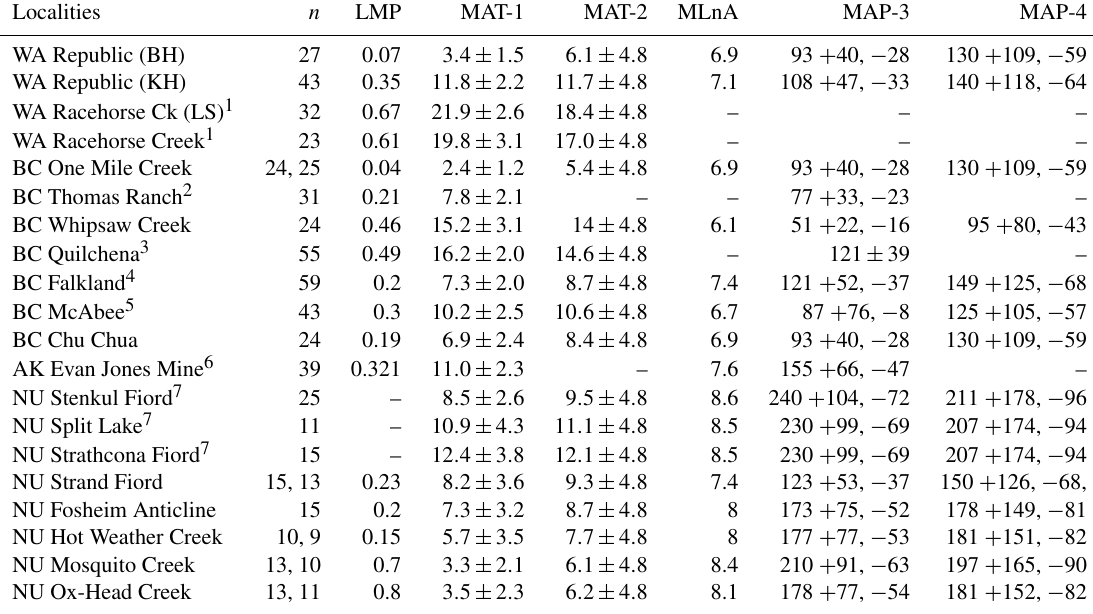
Table A2. Paleoclimate estimates from leaf margin analysis (LMA: Wing and Greenwood, 1993; Wilf, 1997; Peppe et al., 2011) and leaf area analysis (LAA: Wilf et al., 1998; Peppe et al., 2011). Unless otherwise specified, data and estimates are original to this study. See Table 1 for locality data. Errors are stated within the table; errors for MAP are asymmetric as they are converted from log e . Where n has two values, different n applies to LMA and LAA due to overly incomplete leaves being excluded from LAA.